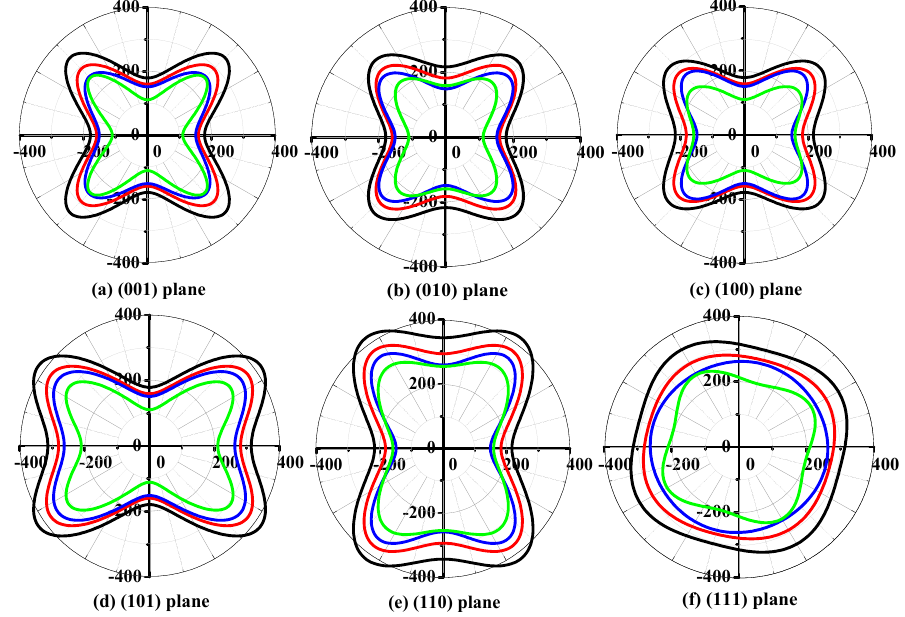
Figure 5. 2D representation of Young’s modulus for t -Si x Ge 3 − x N 4 ( x = 0, 1, 2, 3) alloys in the (001) plane ( a ); (010) plane ( b ); (100) plane ( c ); (101) plane ( d ); (110) plane ( e ); and (111) plane ( f ). The black, red, blue, and green lines represent the Poisson’s ratios of t -Si 3 N 4 , t -Si 2 GeN 4 , t -SiGe 2 N 4 , and t -Ge 3 N 4 , respectively. All units are in GPa.